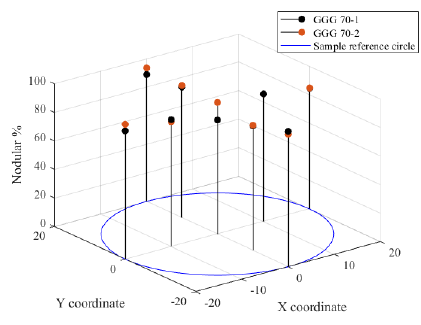
Figure 14. Graphite percentage in